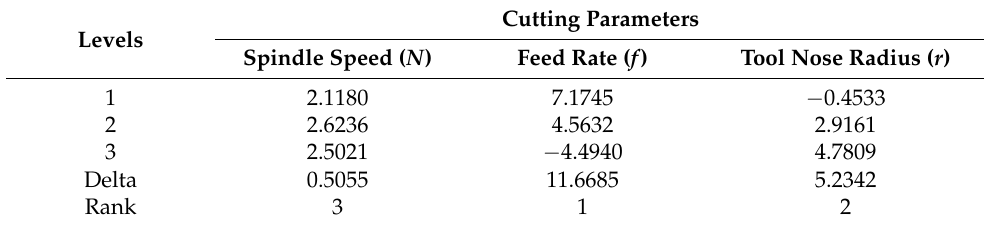
Table 6. S/N ratio response table for surface roughness (R a ) with the